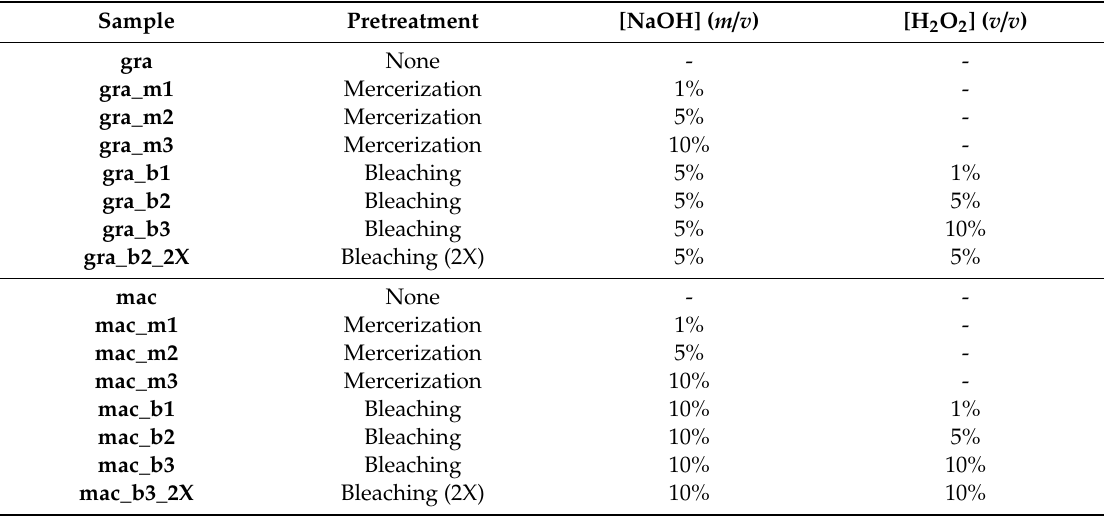
Table 1. Gravata and macauba fiber samples under di ff erent mercerization and bleaching treatments.